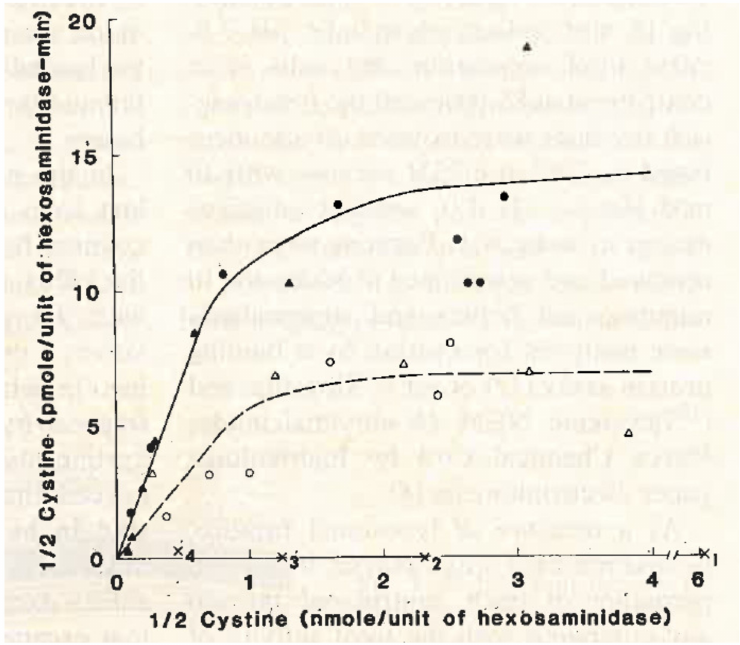
Figure 3. Lysosomes from cystinosis patients (x), their parents (open symbols) and normal controls (filled symbols) were loaded with cystine, and the initial velocity of cystine egress was compared